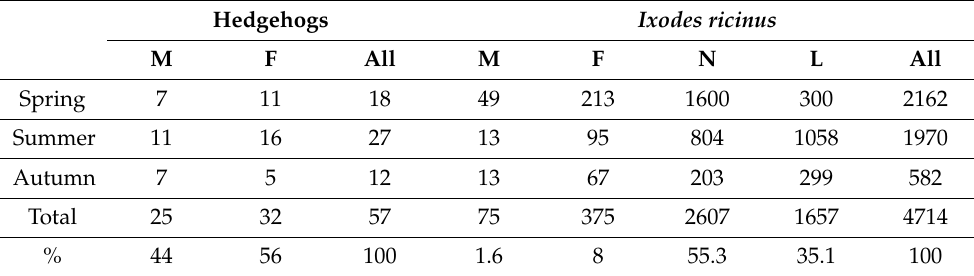
Table 1. Seasonality data of captured hedgehogs and sampled ticks. Hedgehogs Ixodes